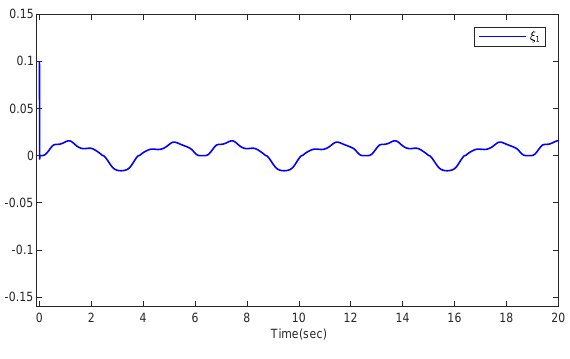
Figure 7. Tracking error ξ 1 .